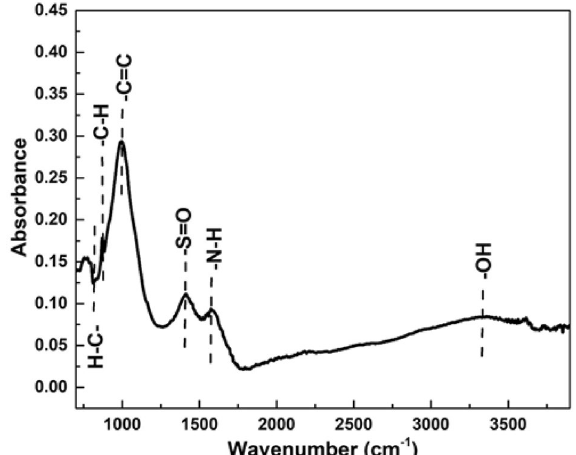
Figure 5. FTIR spectrum of biochar.